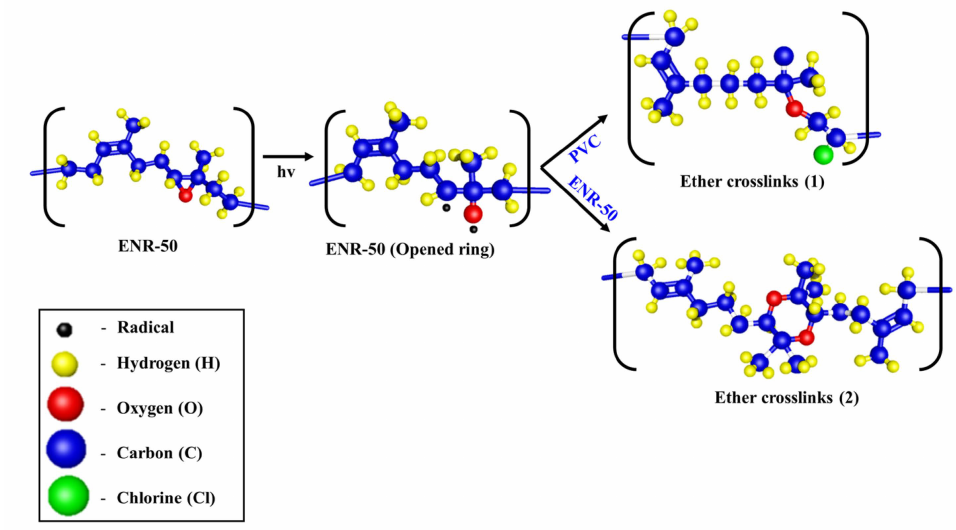
Figure 10. Possible reaction mechanism during the photoetching